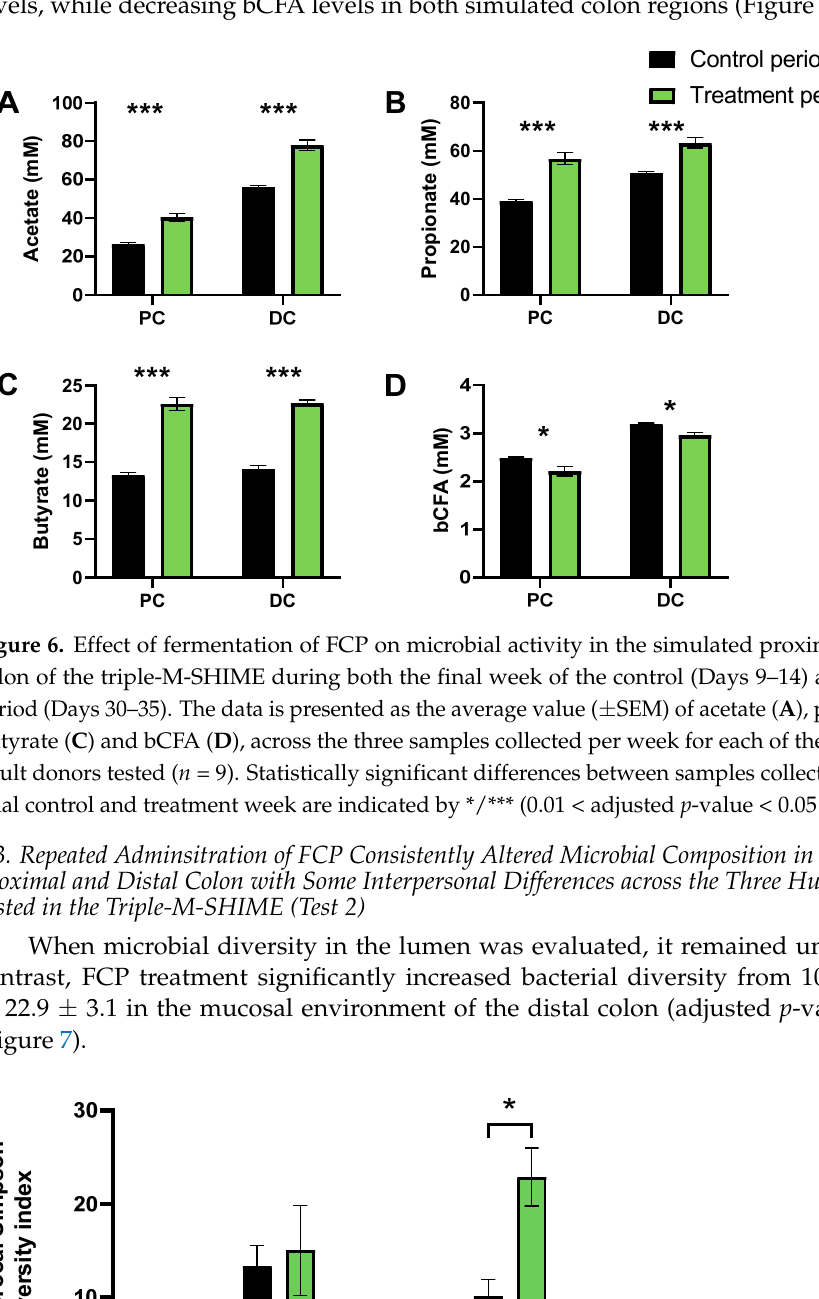
Figure 5. Effect of fermentation of FCP on SCFA levels (mM) in the simulated proximal colon ( A ) and distal colon ( B ) during both the control (Days 0–14) and treatment period (Days 14–35) of the triple-M-SHIME for donor 3. Results are representative of those obtained for Donors 2 and 4 (Sup- plementary Figure S1). Arrows indicate the start of the FCP treatment. levels, while decreasing bCFA levels in both simulated colon regions (Figure 6).